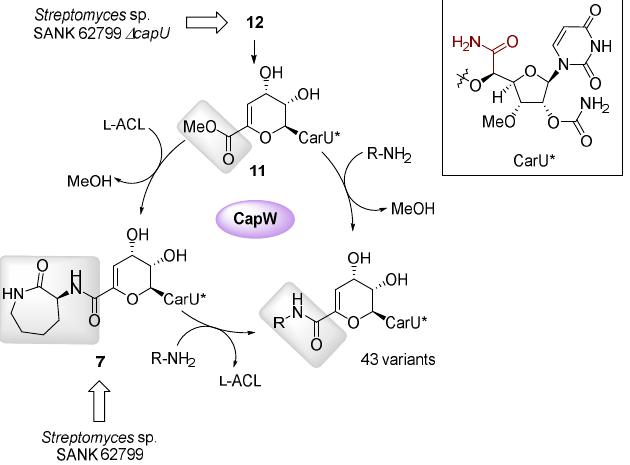
Figure 9. Biocatalytic approach used to synthesize capuramycin analogs.